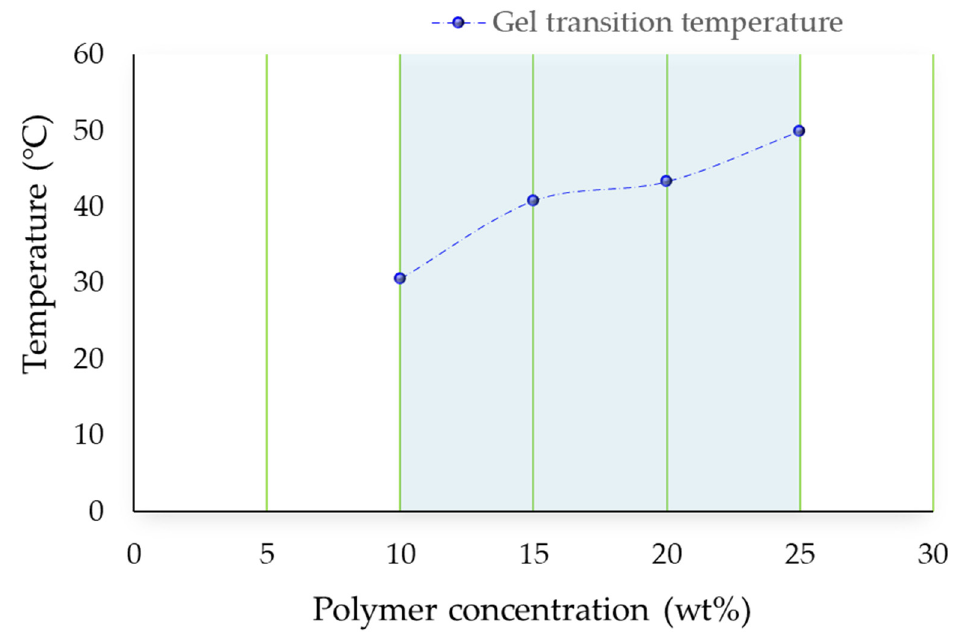
Figure 1. Gel transition phase of PVDF polymer.